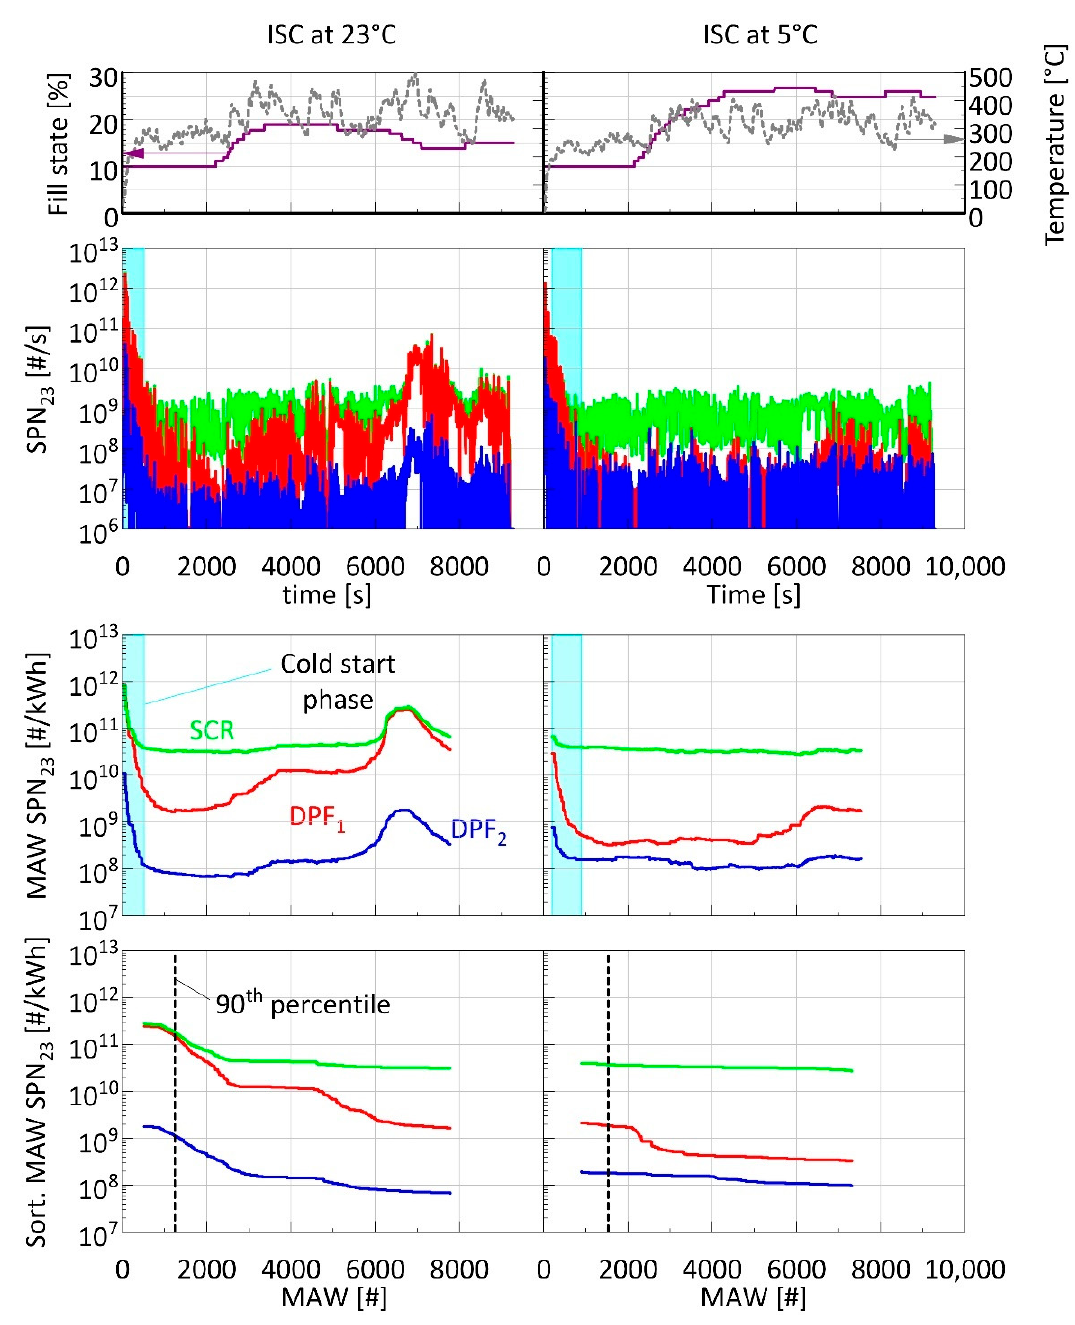
Figure 6. Comparison of the Solid Particle Number (SPN 23 ) real time emission rates (2nd row panels), valid MAW (3rd row panels) and sorted MAW (bottom panels) over the ISC tests with the OEM cDPF at 23 °C (left-hand panels) and 5 °C (right-hand panels). Temperatures at the inlet of the OEM cDPF as well as ECU readings of its fill state are also shown in the top panels. The shaded colored area at the beginning of the tests illustrate the cold phase of the cycles as defined in the Euro VI step E regulation. cDPF = Catalyzed DPF; DPF = Diesel Particulate Filter; ECU = Electronic Control Unit; ISC = In-Service Conformity; OEM = Original Equipment Manufacturer; MAW = Moving Average Window.